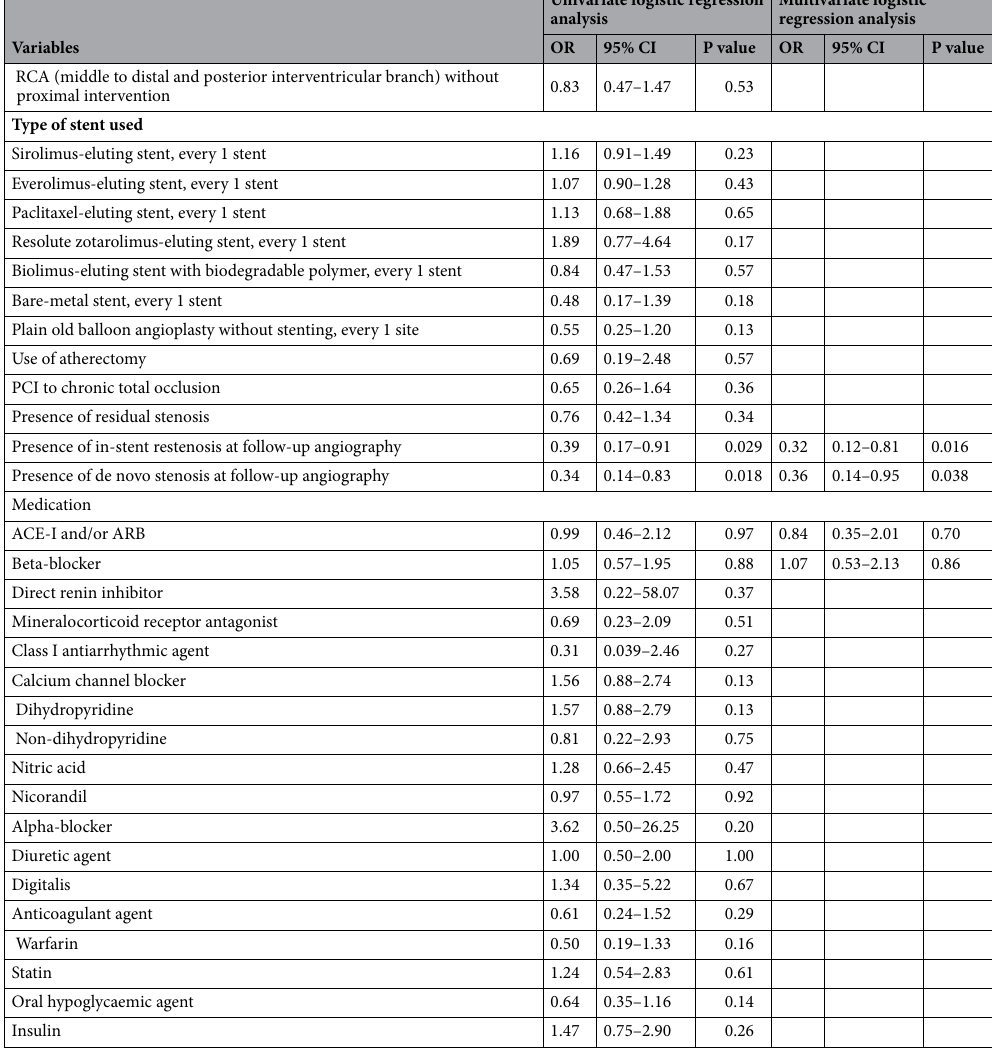
Table 5. Determinants of LVRR: univariate and multivariate logistic regression analysis. Variables that showed a marginal association with LVRR (P < 0.10) in the univariate logistic regression analyses, use of ACE-I/ARB, and use of beta-blocker were adopted as independent variables in the multivariate logistic regression analysis. OR odds ratio; CI confidence